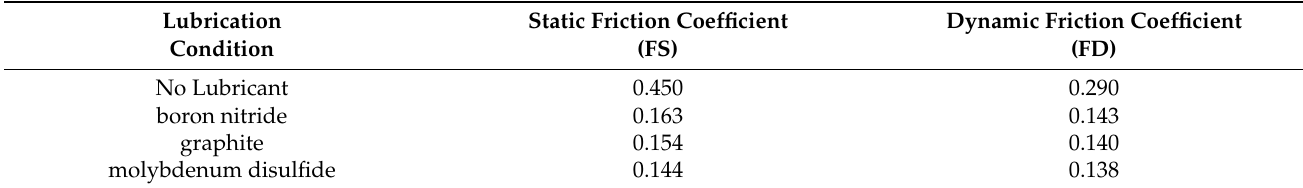
Table 5. Calibrated friction coefficient FS and FD.